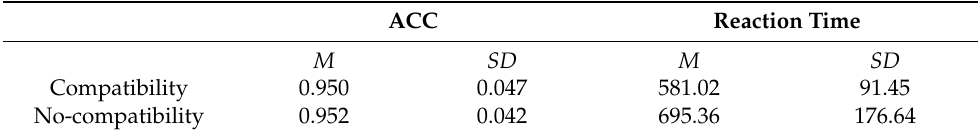
Table 7. The mean ACC and reaction time under different